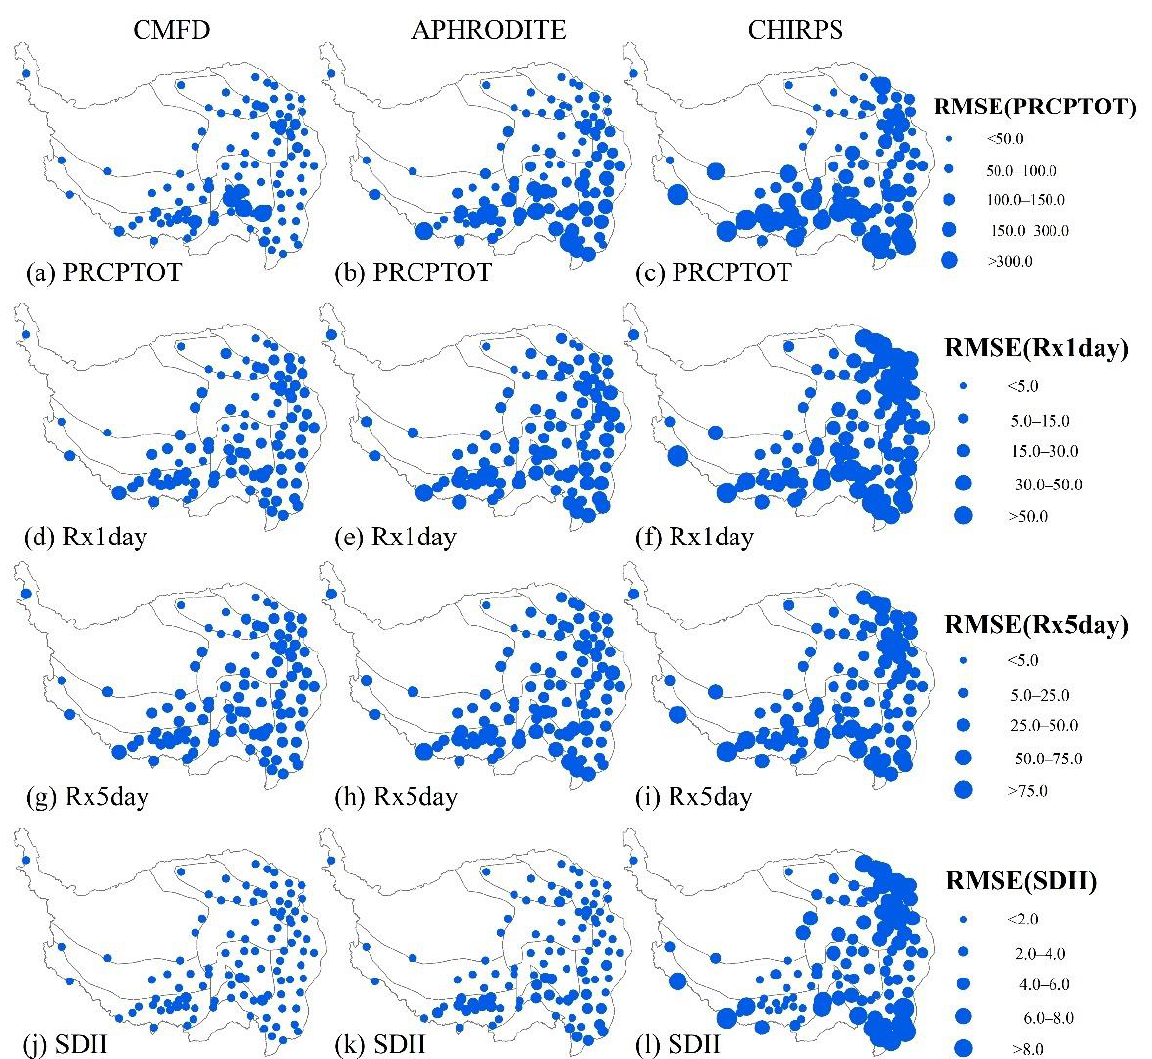
Figure 18. RMSE for gauge-based non-threshold indices PRCPTOT, Rx1day, Rx5day, and SDII as derived from CMFD, APHRODITE, and CHIRPS from 1981 to 2014.